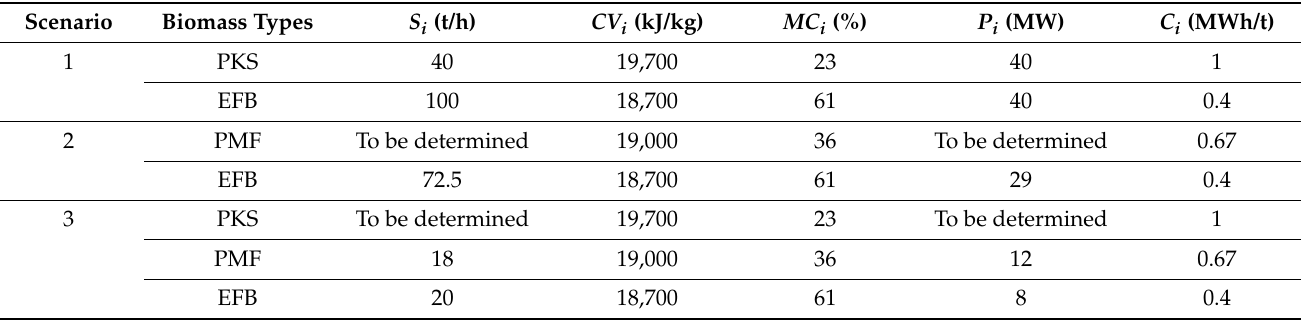
Table 5. Data for biomass in Example 2.